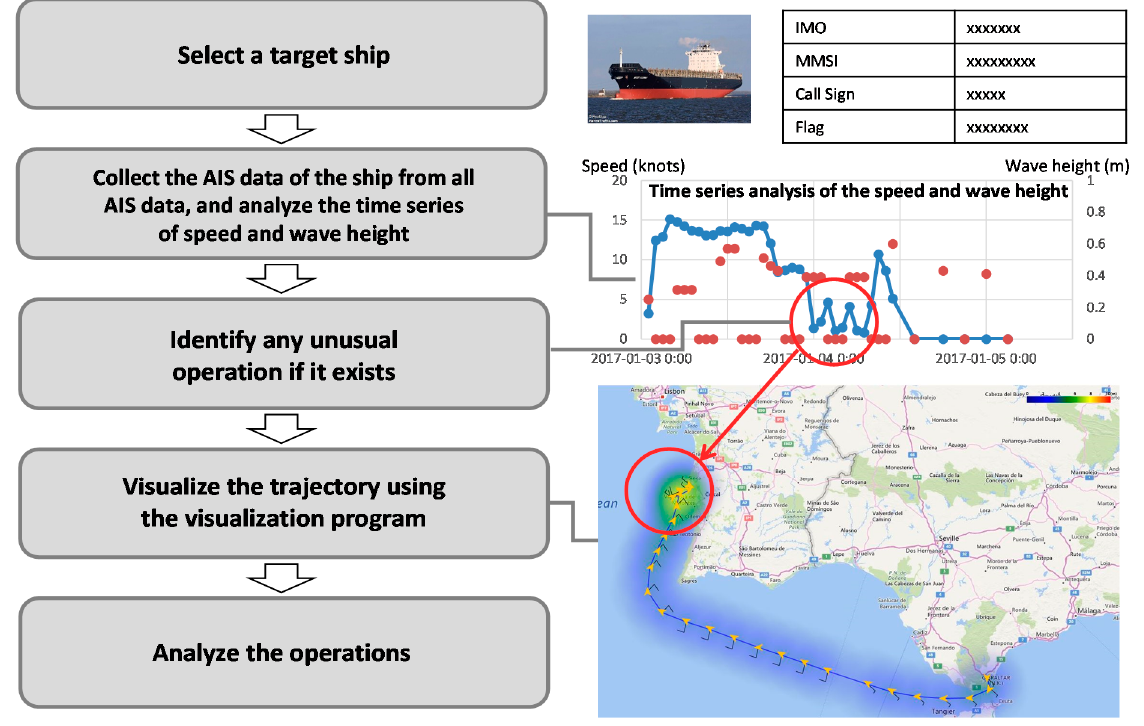
Figure 4. Trajectory analysis process.